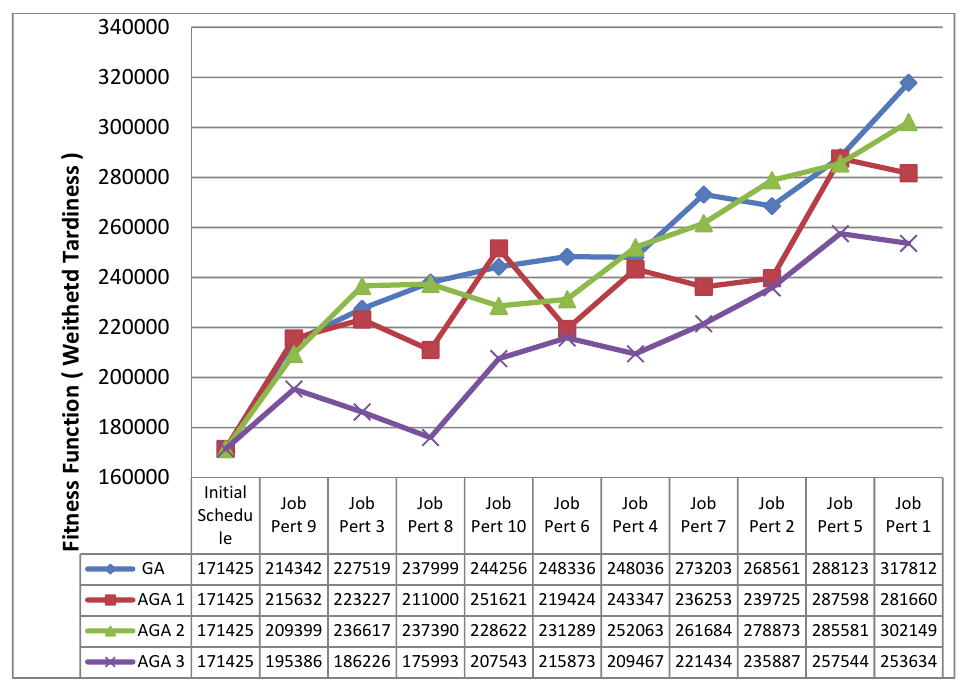
Fig. 2. Comparison of optimal performance in the manufacturing execution